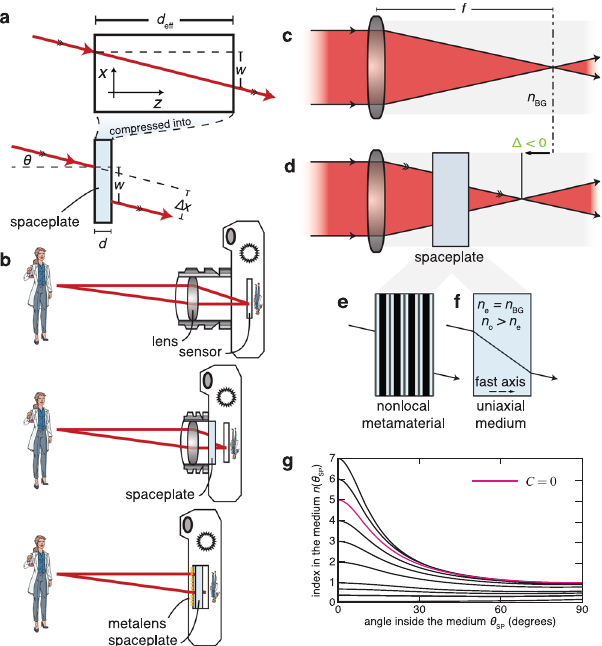
Fig. 1 Operating principle of a spaceplate. a A spaceplate can compress a propagation length of d eff into a thickness d . For example, a beam incident on the spaceplate at angle θ will emerge at that same angle and be transversely translated by length w (resulting in a lateral beam shift Δ x ), just as it would for d eff of free space. b Adding a spaceplate to an imaging system such as a standard camera (top) will shorten the camera